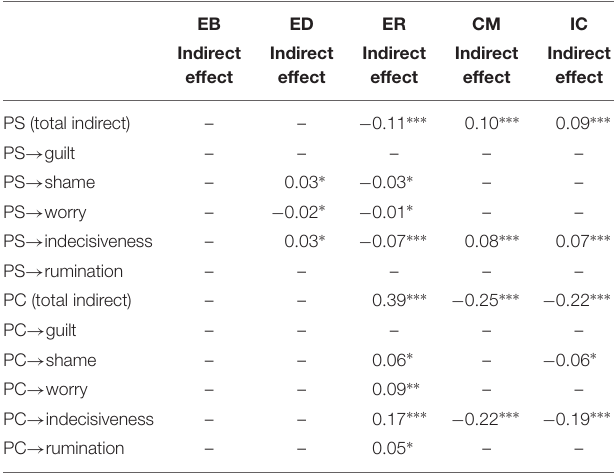
TABLE 3 | Indirect effects of the perfectionism dimensions on the DIDS identity processes via the analyzed mediators. EB ED ER